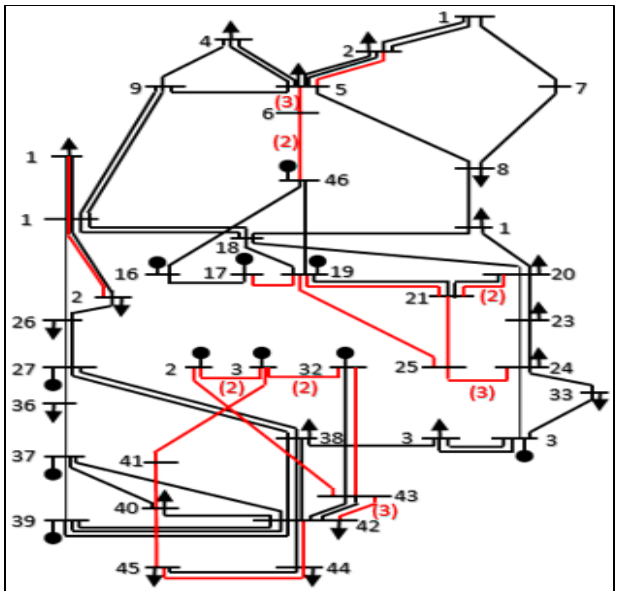
Figure 9: SB -46/79 system – Planned network. Source: Authors, (2021).